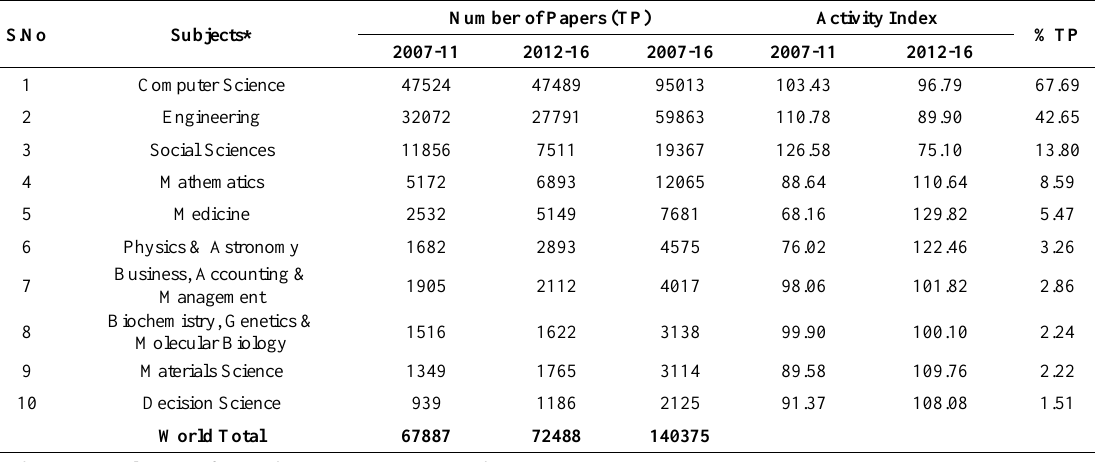
Table 3. Subject-Wise Break-up of Global Publications on Mobile Research during